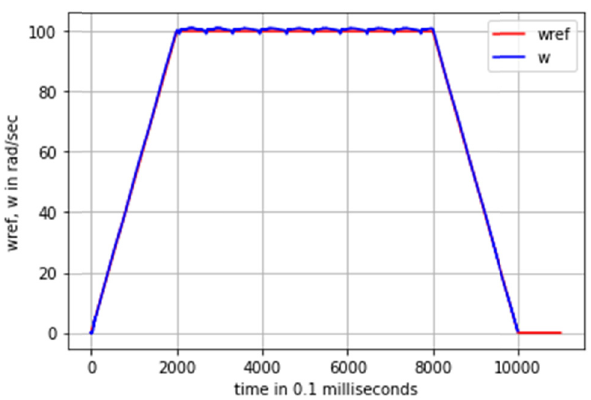
Figure 13: Response of LR control system for disturbance magnitude of 3 × 10 − 1 .